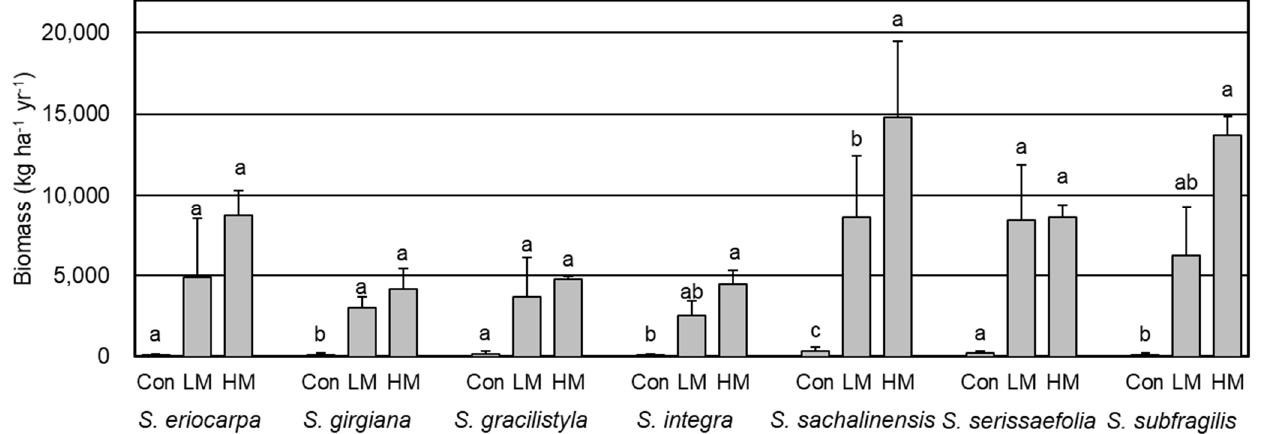
Figure 7. Annual biomass production of seven willows grown under three treatments (mean + SD). The number of samples was four ( n = 4) for S. gilgiana , and two ( n = 2) for other willow species. Asterisks indicate significant differences among seven willows, three treatments, and their interaction (W × T) calculated by ANOVA. Different alphabetical letters indicate significant differences between the three treatments based on Tukey test ( p <